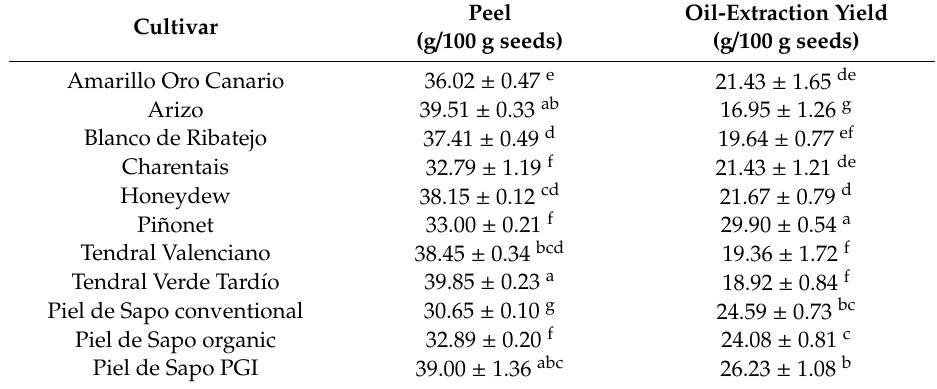
Table 1. Proportion of seed peels and oil-extraction yields obtained with screw press in selected melon cultivars. PGI, Protected Geographical